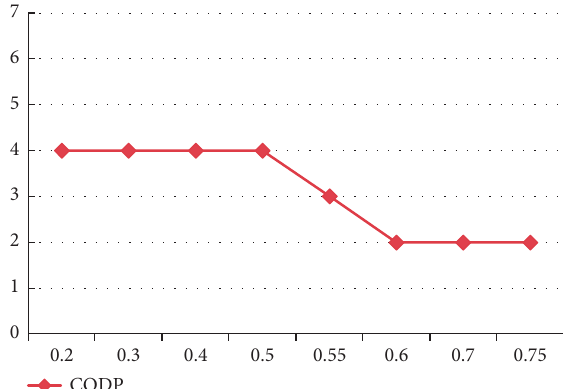
Figure 10: Optimal CODP when different β values are taken.